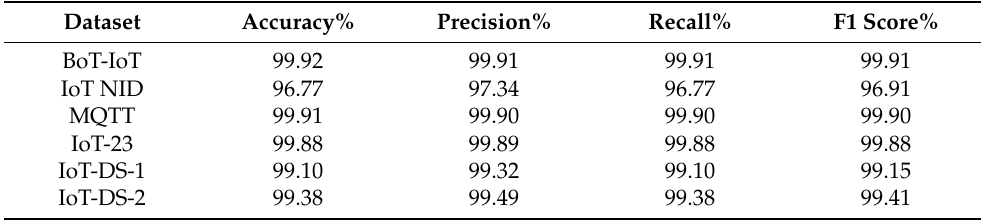
Table 8. Average multiclass classification accuracy, precision, recall, and F1 score.